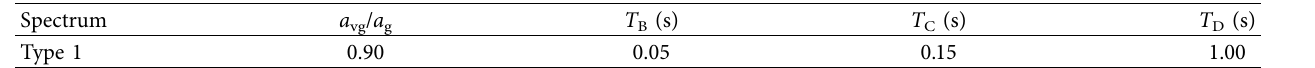
Figure 2: Comparison of the damping correction factors in Eurocode 8 and the Chinese specification. Table 2: Parameters of the vertical elastic response spectra in Eurocode 8.